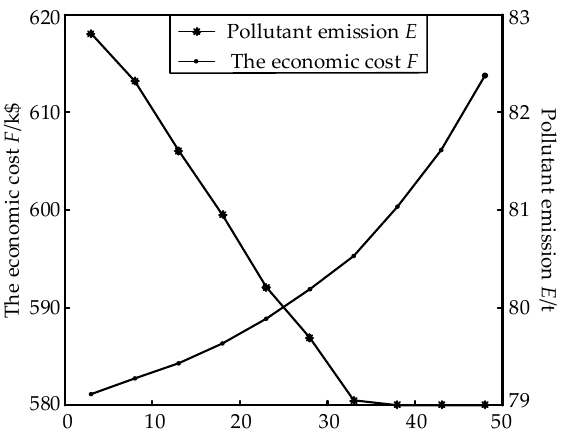
Figure 7. The economic cost and pollutant emission with different price of green certificate fines.